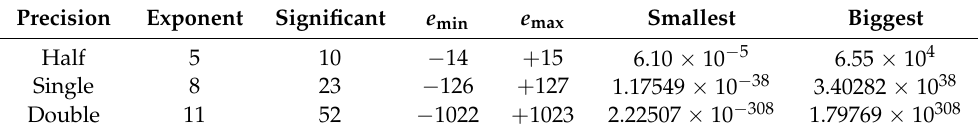
Table 1. Characteristics of floating point (FP) numbers in the IEEE 754